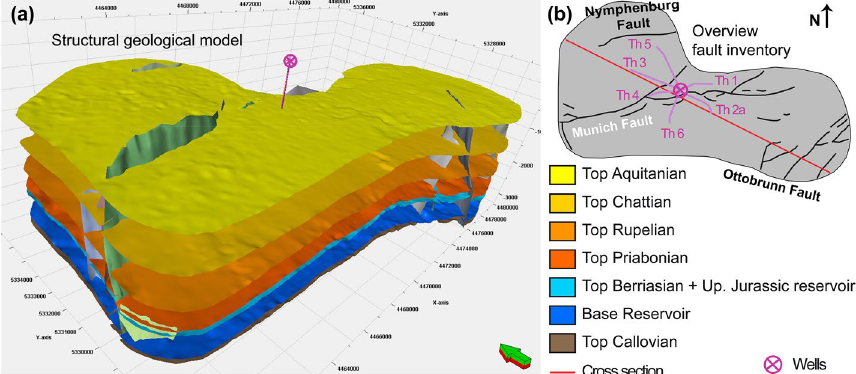
Fig. 3 Structural geological model of the Munich area with color-coded marker horizons based on the GRAME 3D seismic data set ( a ), and overview of the fault inventory and the well paths of the six Schäftlarnstraße boreholes Th1–Th6 ( b ). The cross section marked by the red line is shown in Fig.